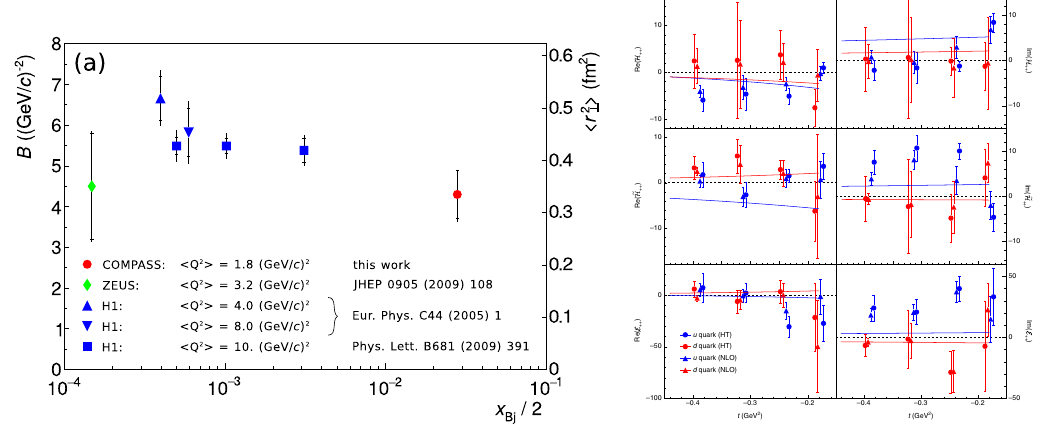
Fig. 6 | Flavour separation of helicity-conserved CFFs. The points represent the real and imaginary parts of u and d helicity-conserved CFFs H þþ I , ~ H þþ I and E þþ I in both the HT and NLO scenarios. The error bars correspond to 1 s.d. and take into account the statistical and the systematic uncertainties of the fitted cross-sections. Solid lines present the predictions of a reggeized diquark model of GPDs 51,52 . Figure 6: Left: COMPASS DVCS t -slope and comparison to HERA ep -collider (H1 and ZEUS) data [ 50 ] . Right: JLab Hall A - real and imaginary parts of various Compton form factors for u - and d -quarks [ 52 ]